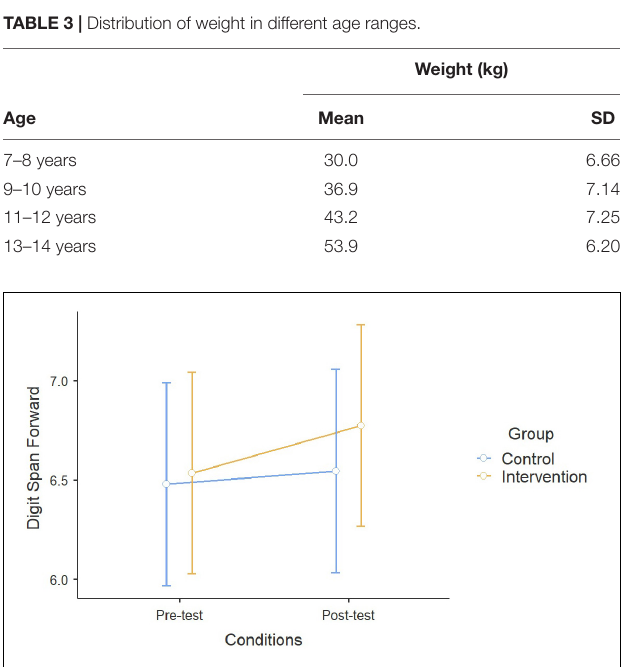
FIGURE 2 | Results on the Digit Span Forward.